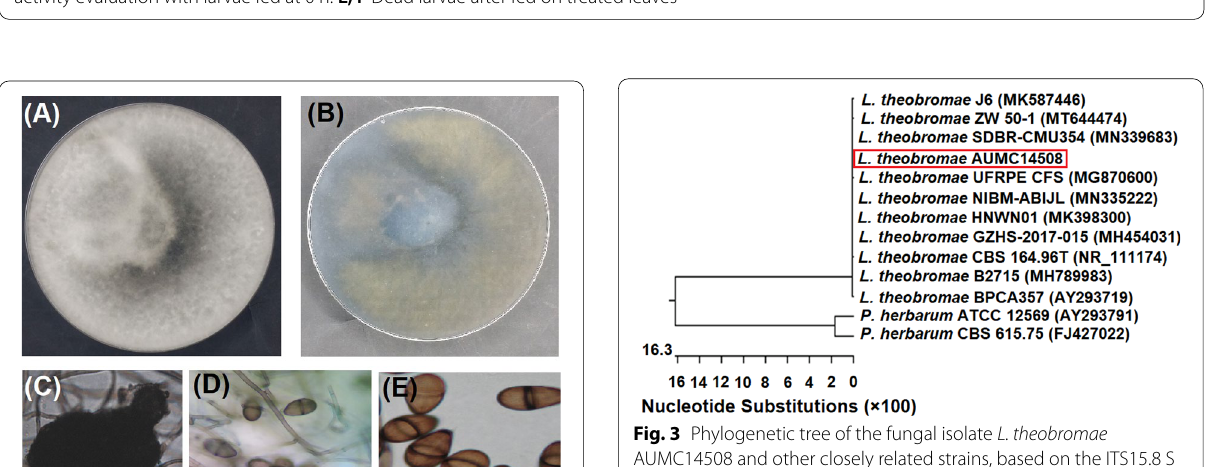
Fig. 1 Photographs of the 3rd instar Spodoptera littoralis larvae feeding on castor leaves. A Leaf discs used in antifeedant activity evaluation after treatment. B Control untreated leaf discs with larvae after 48 h. C Treated discs with larvae fed after 24 h. D Treated castor leaves used in larvicidal activity evaluation with larvae fed at 0 h. E, F Dead larvae after fed on treated leaves